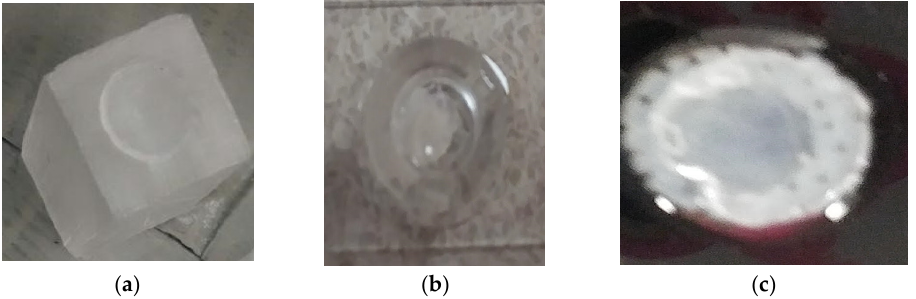
Figure 3. ( a ) PCL NFM coated PEGDA scaffold on an acrylic mold; ( b ) Cured SA gel on microscopy slide; ( c ) A PCL coated CG1 sample on a plastic